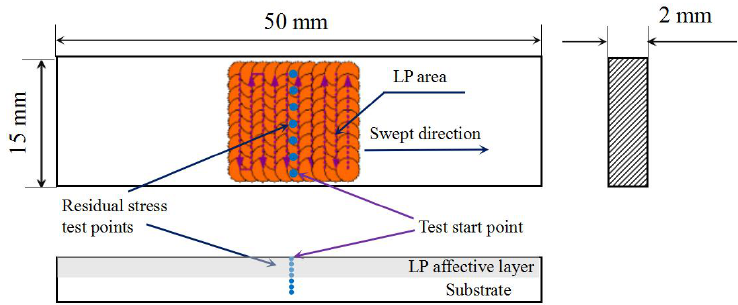
Figure 1. Dimension of specimen and treated area.